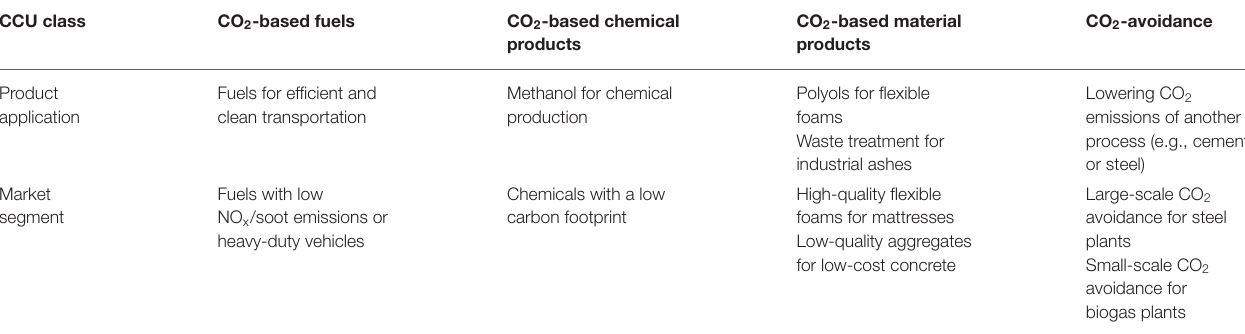
TABLE 2 | Examples of CCU product applications and market segments (not